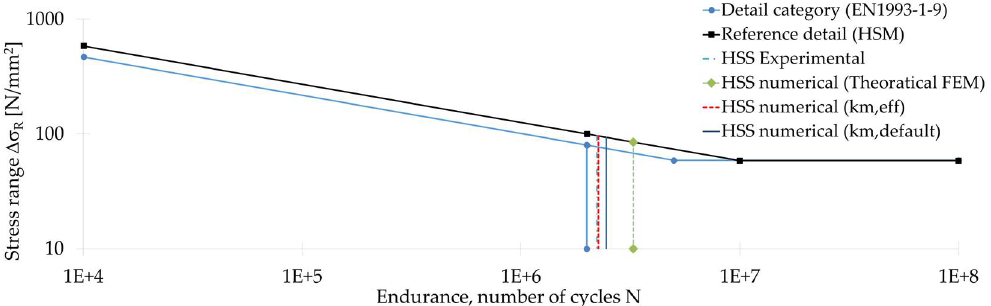
Figure 5. Fatigue endurance of the analysed detail based on SHSS method.